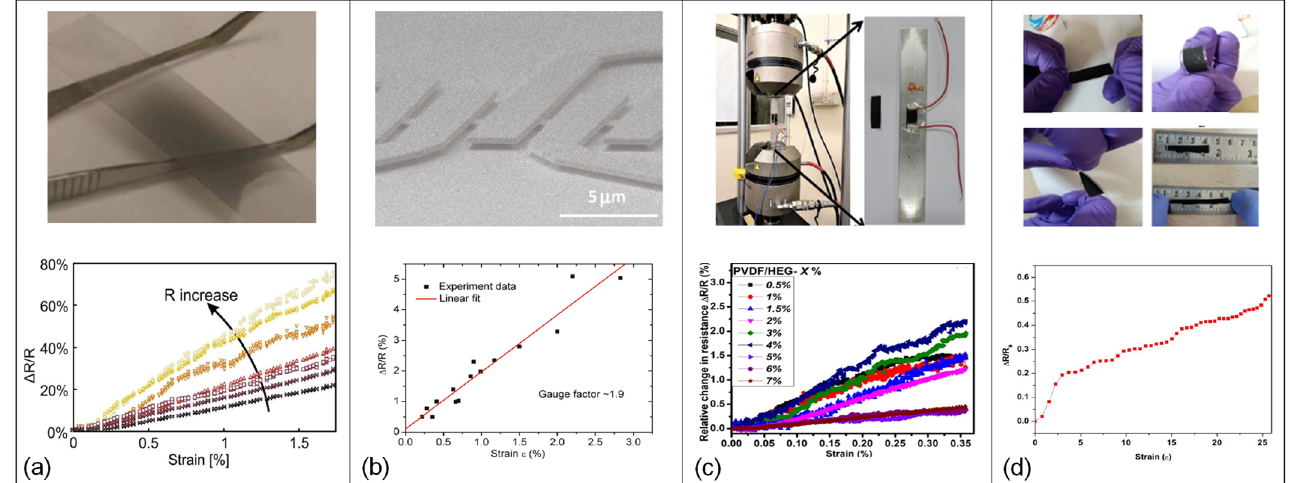
Figure 6. Exfoliated graphene-based strain gauges ( a ) Sample of graphene film and curves of normalized change in electrical resistance versus strain for several strain gauges. Adapted with permission from ref. [154]. Copyright (2012) American Chemical Society. ( b ) SEM image of four suspended graphene devices made from a single flake and the electrical measurements of uniaxially strained graphene (relative change of resistance as function of strain). Adapted with permission from ref. [159]. Copyright (2011) American Chemical Society. ( c ) Piezoresistive measurement of the fabricated strain sensor on the aluminum specimen, which is under uniaxial tensile loading and relative change in resistance against applied strain [161]. ( d ) Optical photographs of fabricated GNP/PDMS strain sensor at stretchable, foldable, twistable and demonstration of fabricated GNP strain sensor and relative resistance versus strain [162] .